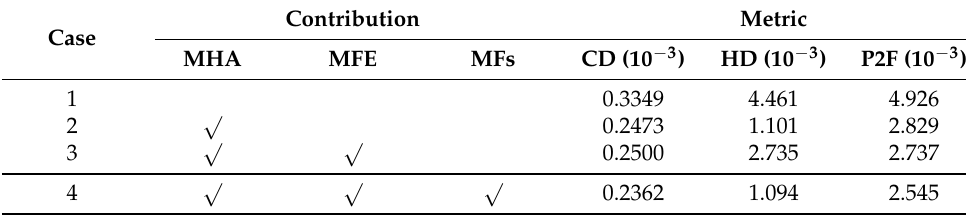
Table 4. Ablation study results to analyze the effect of the present